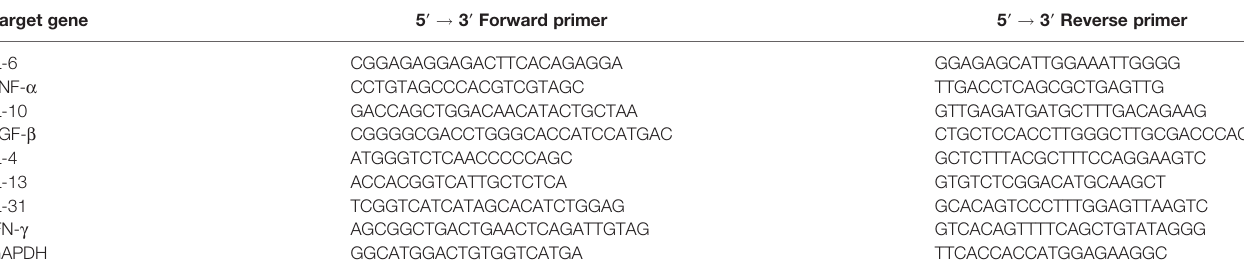
TABLE 1 | Sequence of reverse transcription PCR primers. Target